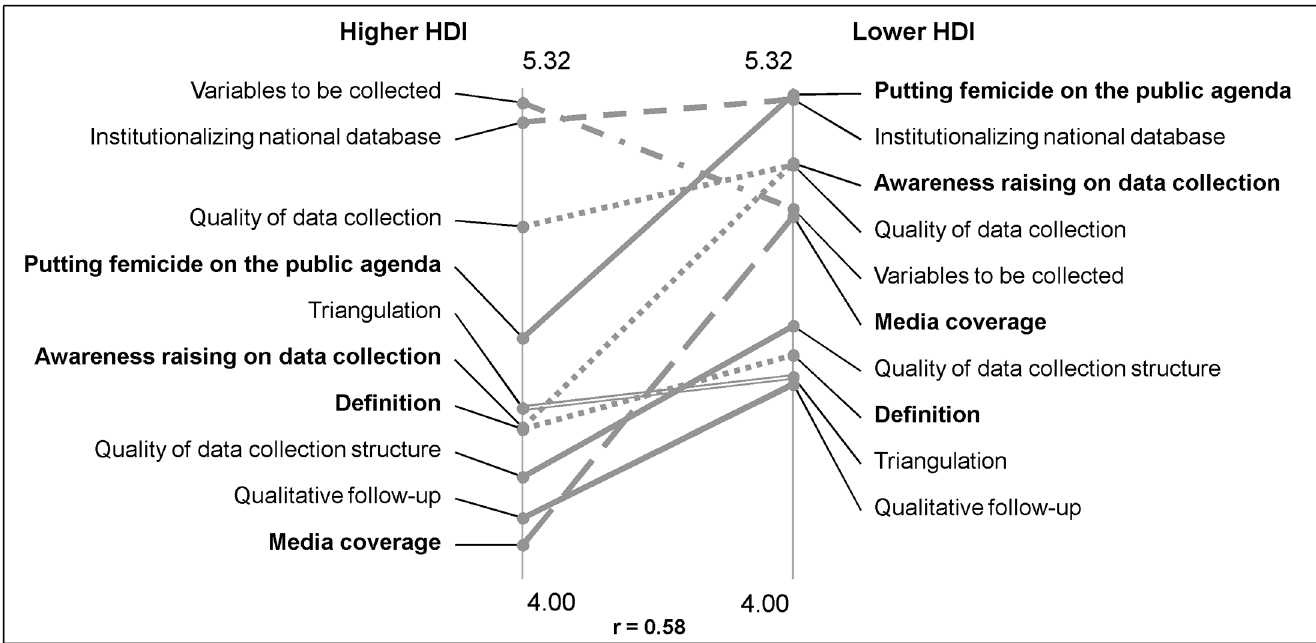
Fig 2. Comparison of average cluster relevance ratings by countries with higher and lower HDI. The clusters with significant difference in the domain of “ Political awareness ” are highlighted in bold.